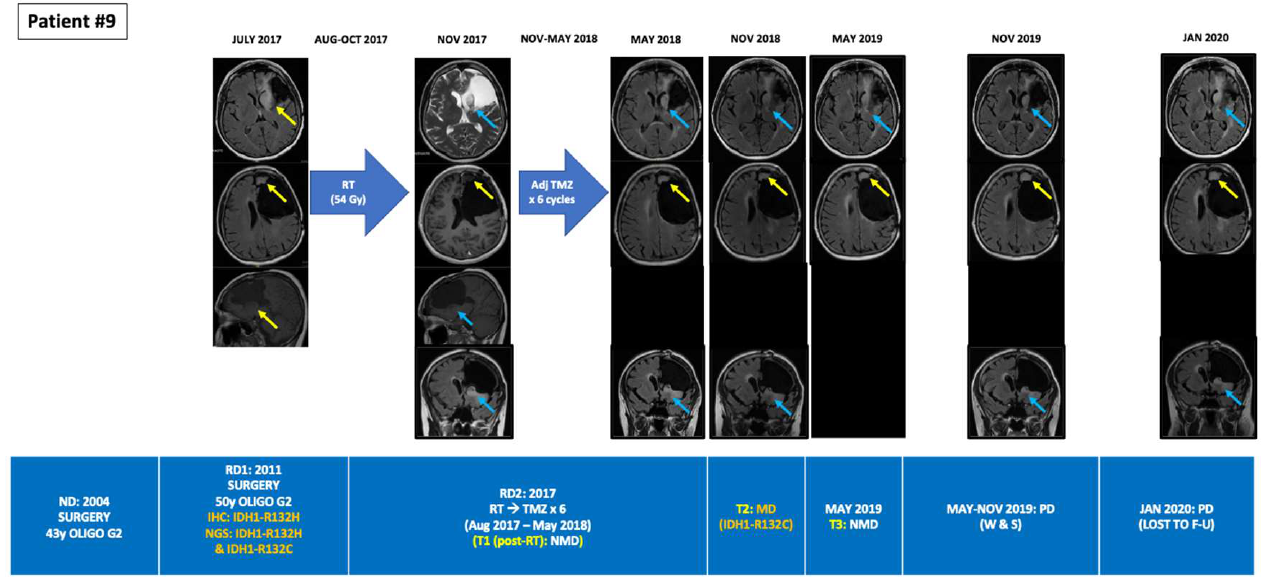
Figure 3. Tumour evolution in BEAMing ctDNA-positive patient #9. A 58-year-old woman was diagnosed in 2004 of a grade II oligodendrogliomas undergoing a gross total resection. In 2011 the tumor relapsed, undergoing a subtotal resection with aphasia as a postsurgical sequel. The patient then received adjuvant TMZ for 12 cycles. RT was disregarded due to the potential sequelae given the large volume to irradiate. In July 2017, the patient suffered an unresectable relapse. NGS analysis of the 2011 archived tumor sample unveiled two co-existing mutations in IDH1 (R132H and R132C). RT (54 Gy in 30 fractions) was administered between August and October 2017. BEAMing plasma ctDNA analysis did not detect any mutation prior to RT. After RT the patient received adjuvant TMZ for 6 cycles. Partial response was observed after RT, but progressive disease occurred in the antero-medial surgical cavity margin from May 2018 until January 2020, when the patient was lost to follow up. In May 2018, after finishing adjuvant TMZ, BEAMing plasma ctDNA analysis detected one of the IDH1 mutations detected in the tumor resected in 2011 (ctDNA IDH1-R132C VAF 0.025%, which is above de LOD for BEAMing (>0.02%)). However, ctDNA analysis